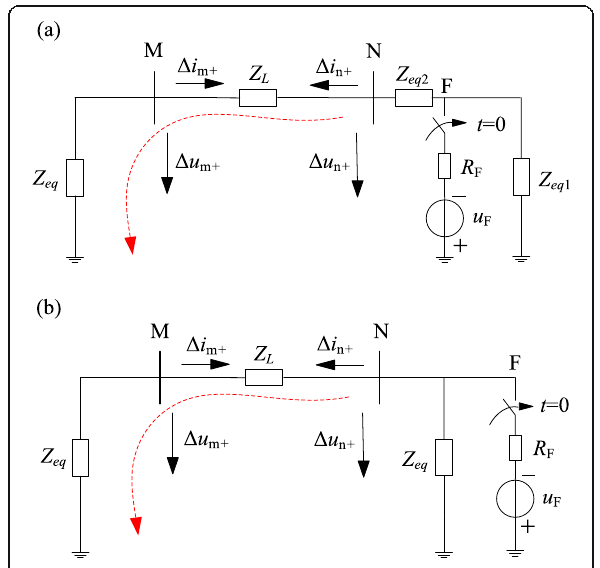
Fig. 5 Fault superimposed circuit for a fault occurring on the inverter side. a Fault occurring on the converter valve or DC bus. b Fault occurring on the AC